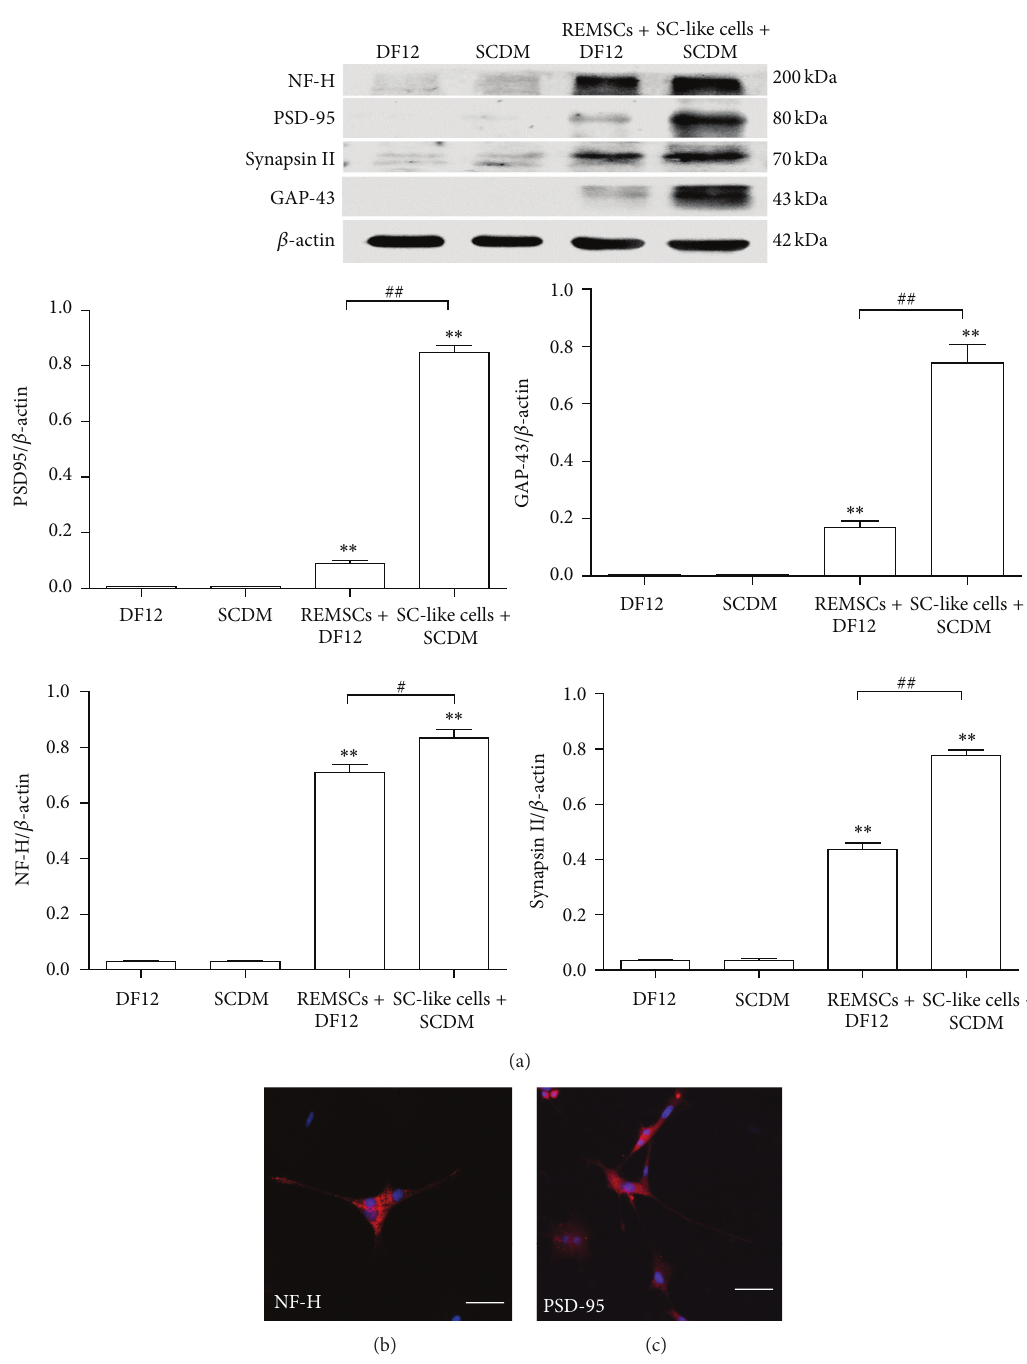
Figure 6: Western blot and immunofluorescent labeling indicated that SC-like cells promoted the differentiation of PC12 cells into mature neuron-like cells. (a) Neural cell markers including NF-H, GAP-43, PSD-95, and Synapsin II were detected in PC12 cells after being cultured for 5 days for all four groups, which were PC12 cells treated with DF12 medium, PC12 cells treated with SCDM, PC12 cells treated with DF12 medium and REMSCs, and PC12 cells treated with SC-like cells and SCDM. 𝛽 -Actin was used as a loading control. The experiments were replicated three times and a representative blotting was shown. Each bar showed the ratio of marker protein to 𝛽 -actin. The data were presented as the mean ± SEM of three independent experiments. ∗∗ 𝑃 < 0.01 represent significant differences compared with group A; ## 𝑃 < 0.01 represent significant differences compared with group C. Immunofluorescent staining showed that differentiated PC12 cells in group D expressed NF-H (b) and PSD-95 (c). Bar: 50 𝜇 m for all